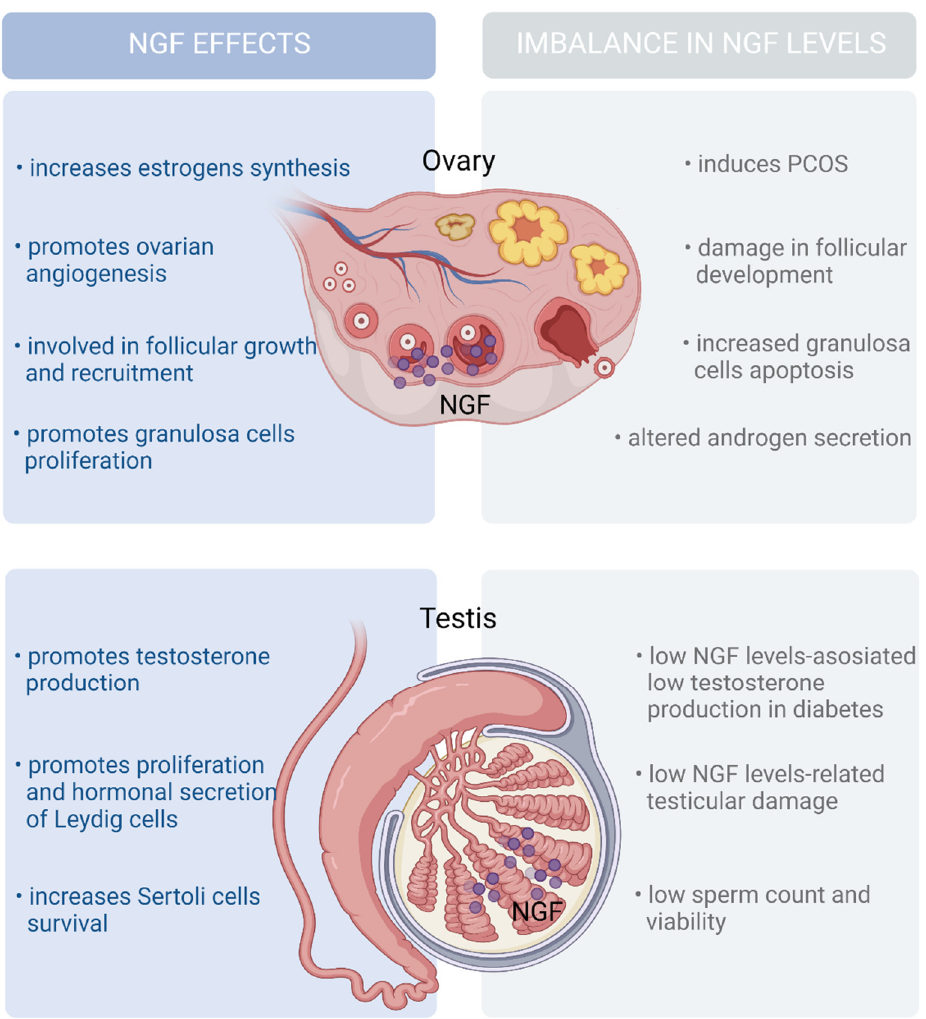
Figure 5. NGF effects on gonads. The ovaries and testes express NGF and its receptors. NGF participates in the development of reproductive function by modulating gametogenesis, angiogenesis, cell proliferation, and the secretion of steroid hormones in gonads. Alterations in NGF synthesis and signaling favor an imbalance in the synthesis of androgens and estrogens, which induces the development of PCOS, infertility, and tissue damage, among others. These abnormalities in sexual function have been linked to metabolic dysfunction such as insulin resistance or type 2 diabetes.